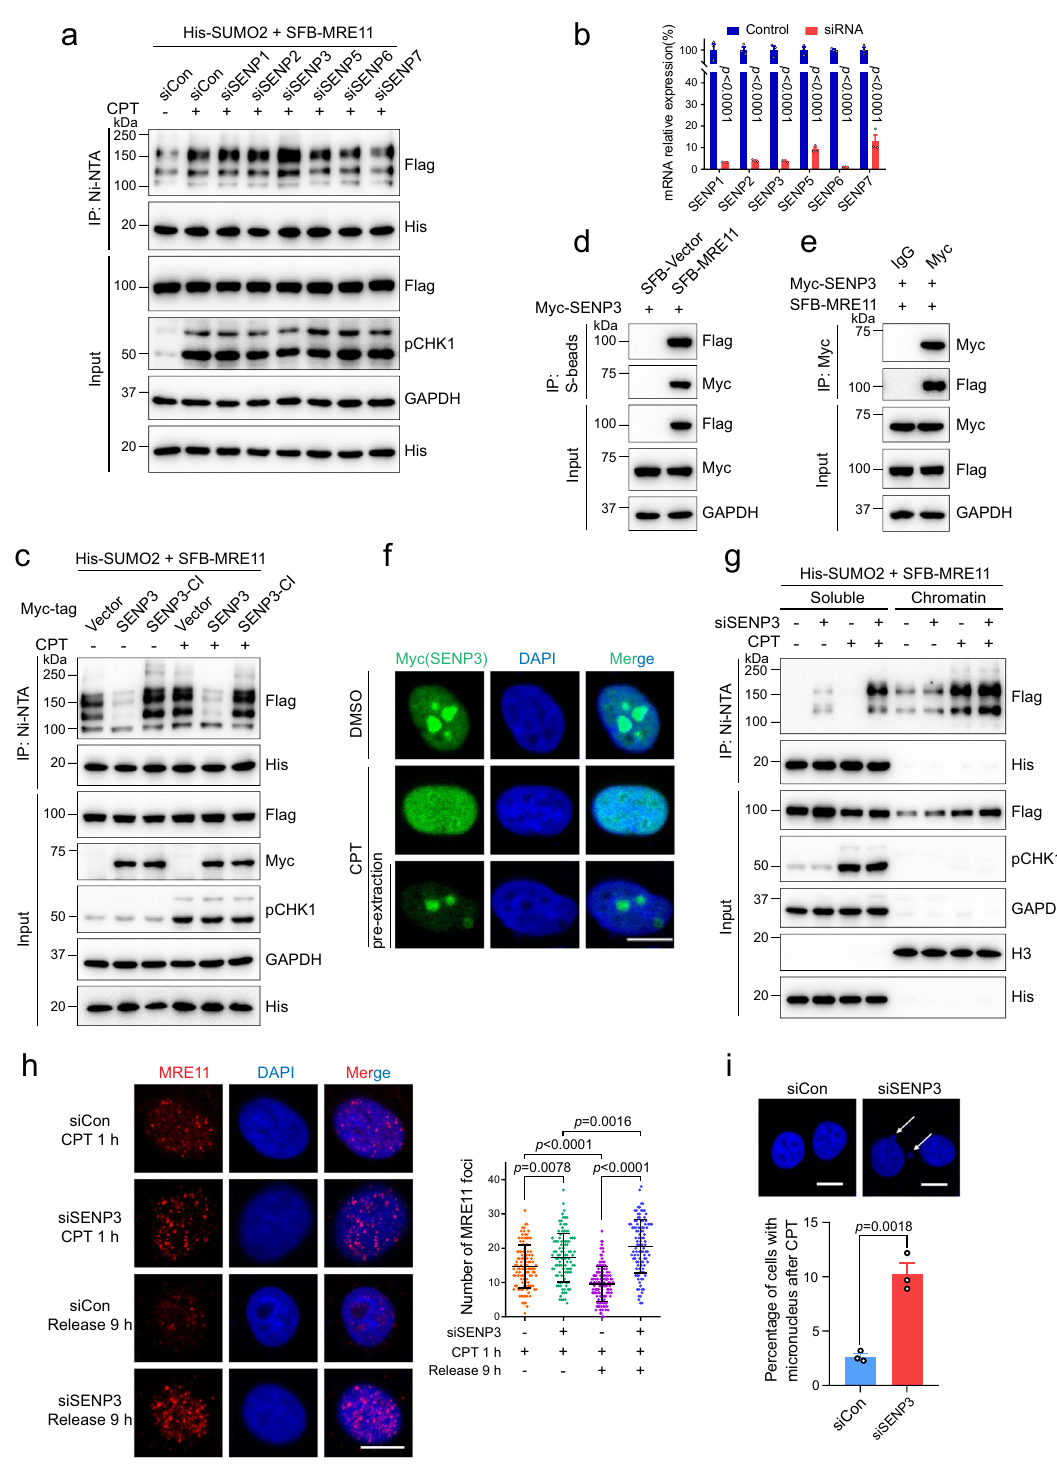
Soluble fractions and chromatin fractions